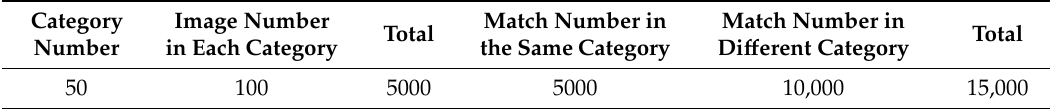
Table 19. The number of iris categories and the number of single-category